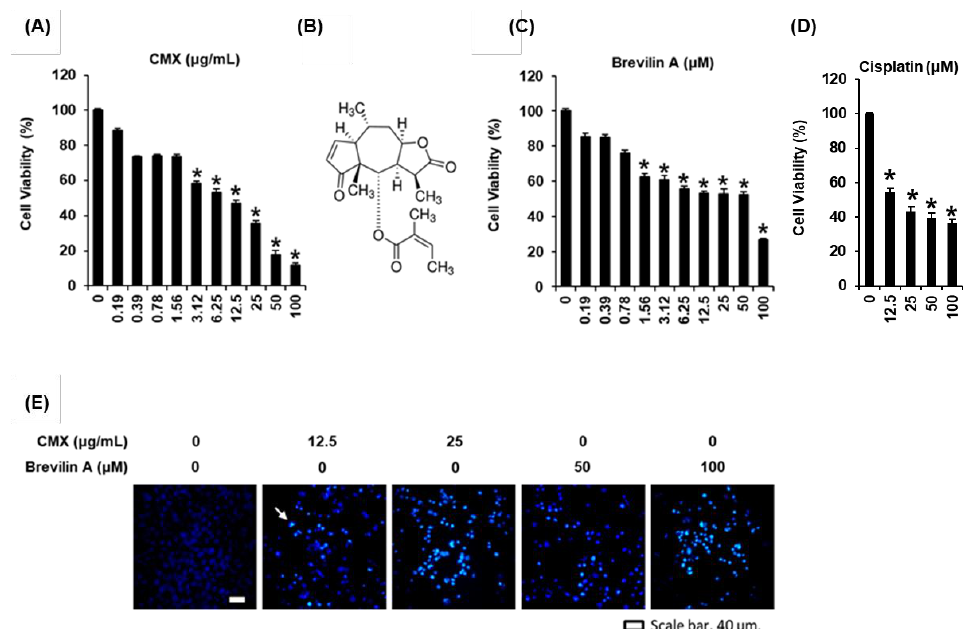
Figure 6. The cytotoxic effects of extracts of Centipeda minima (CMX) and brevilin A on AGS human gastric cancer cells. ( A ) The dose-dependent effect of CMX on the viability of AGS cells. ( B ) The chemical structures of brevilin A. The dose-dependent effect of ( C ) brevilin A and ( D ) cisplatin on the viability of AGS cells. ( E ) Hoechst 33342 staining of AGS cells treated with CMX and brevilin A. Brightly stained condensed nuclei (white arrow). Scale bar, 40 µm. The experiments were performed in triplicate. The error bars represent the standard deviation of samples (n = 3). * p < 0.05 compared with that of the control.